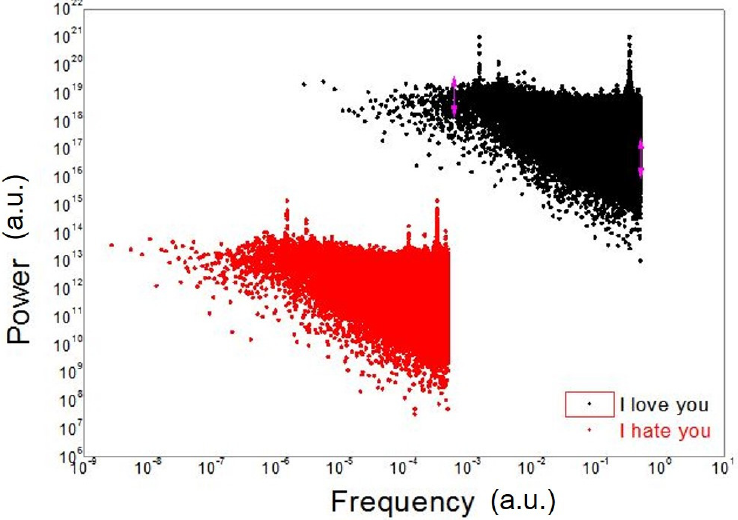
Figure 2. FFT of the “I love you (ti amo)” (black points, upper graph) and “I hate you (ti odio)” (red points, lower graph) signals used in our previous work [8].